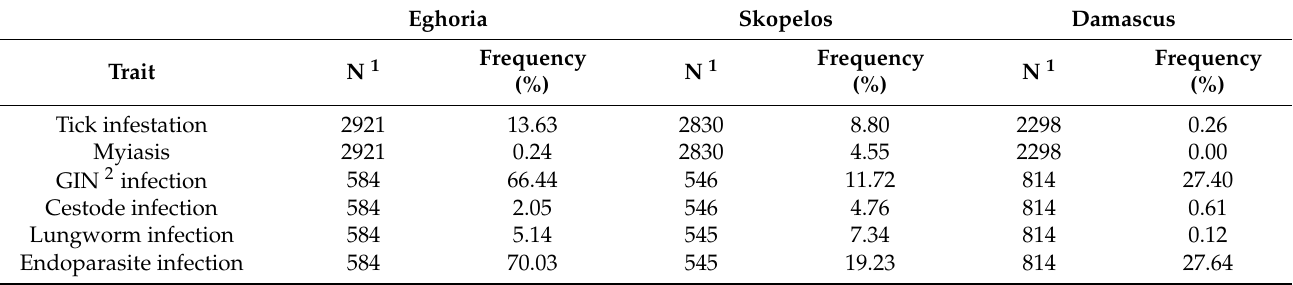
Table 3. Frequency (%) of parasitism in the studied goat breeds.